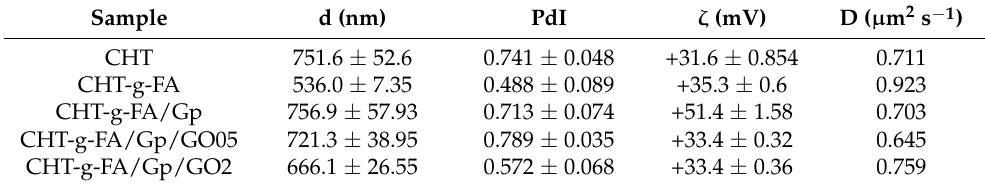
Table 1. Hydrodynamic features of precursor polymer and newly developed